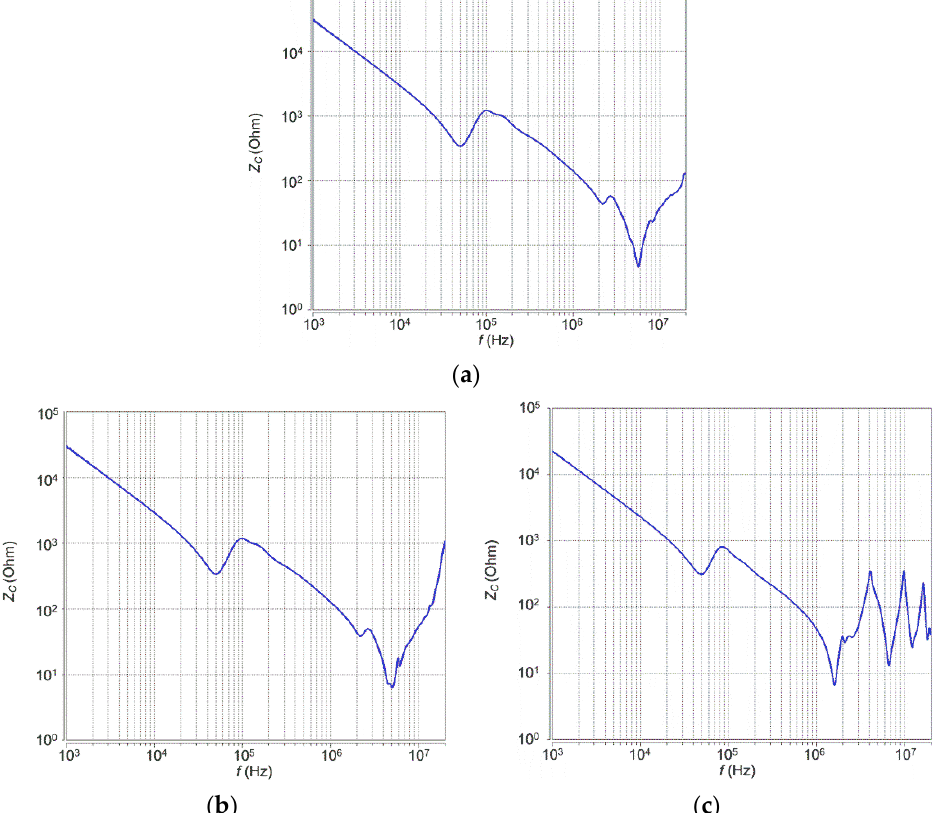
Figure 14. Measured impedance Z C (f) frequency characteristics: ( a ) motor; ( b ) motor with 1 m cable; ( c ) motor with 10 m cable.